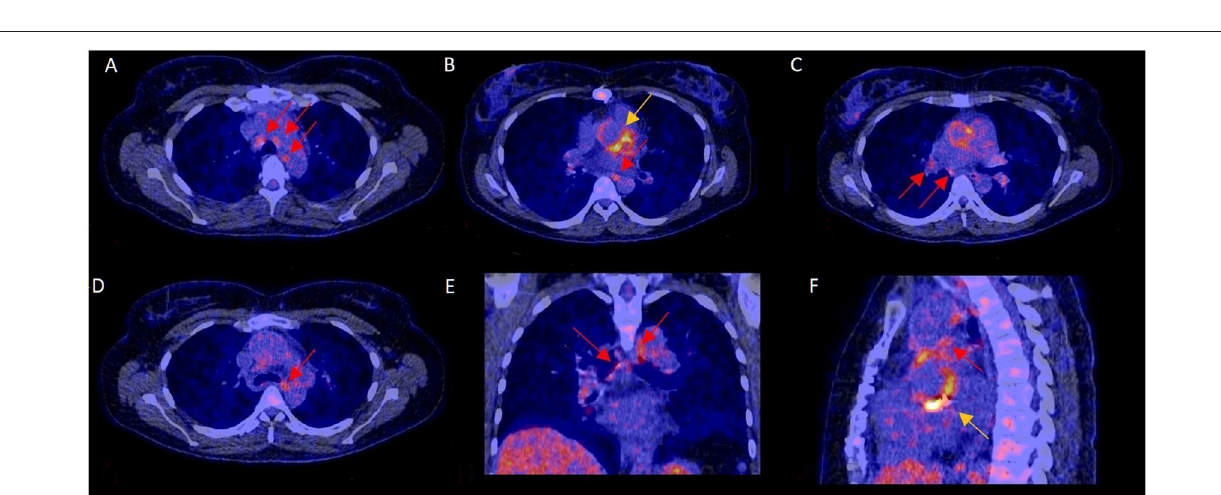
FIGURE 1 | Overview of patient groups according to clinical and PET/CT results for mediastinal lymph nodes in diagnosing PVE. Legend: Correct classifications in green, misclassifications in red.